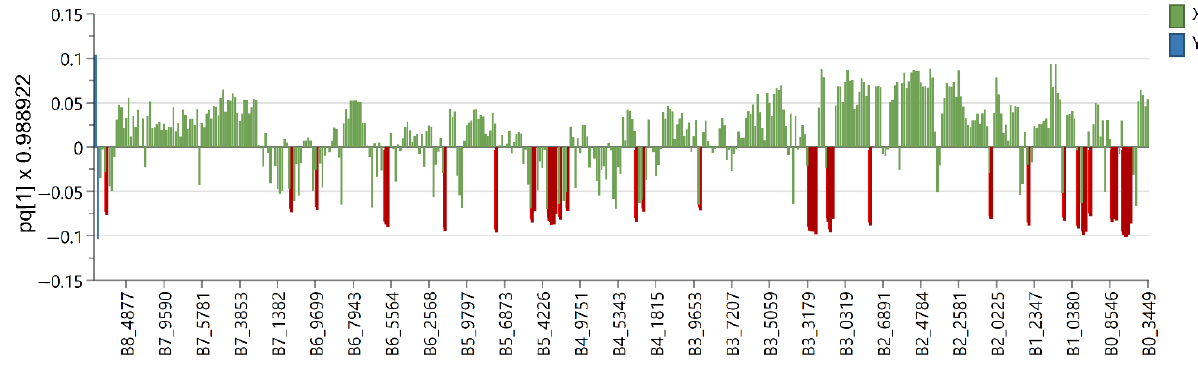
Figure 9. Loading plot with red and brown marked variables characteristic for E. maculata (Y variables—loading vectors scaled to unit length) in comparison to other species (X variables—chemical shift), obtained from the OPLS-DA model.